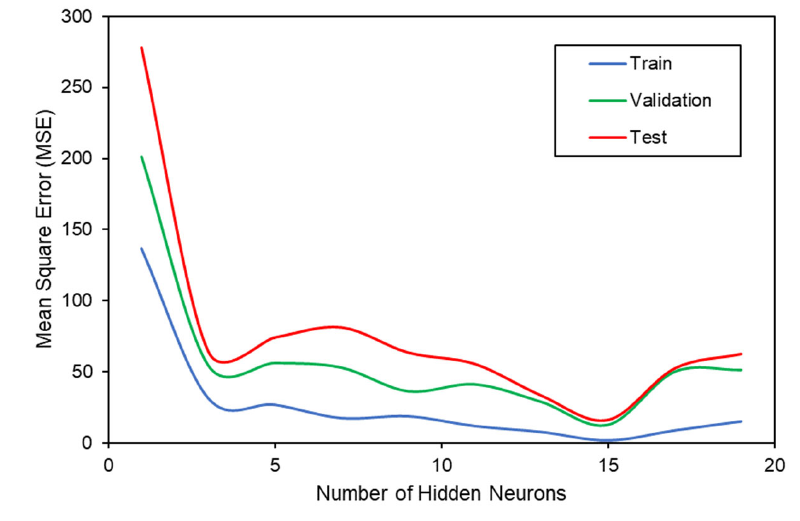
Figure 2. The change in the values of mean squared error against the number of neurons in the designed ANN.